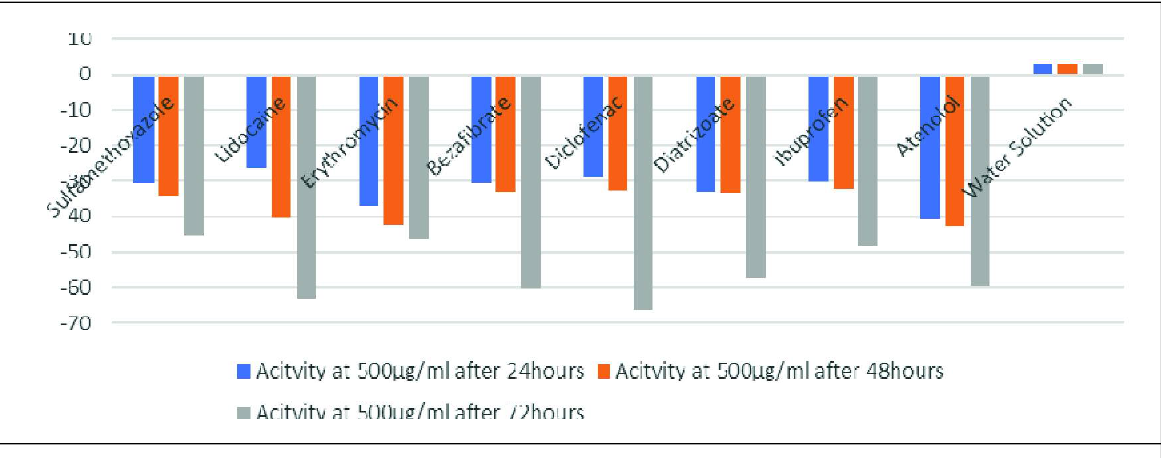
Figure 3: Chronic growth stimulation and inhibition of Bacillus subtilis at 500 µ